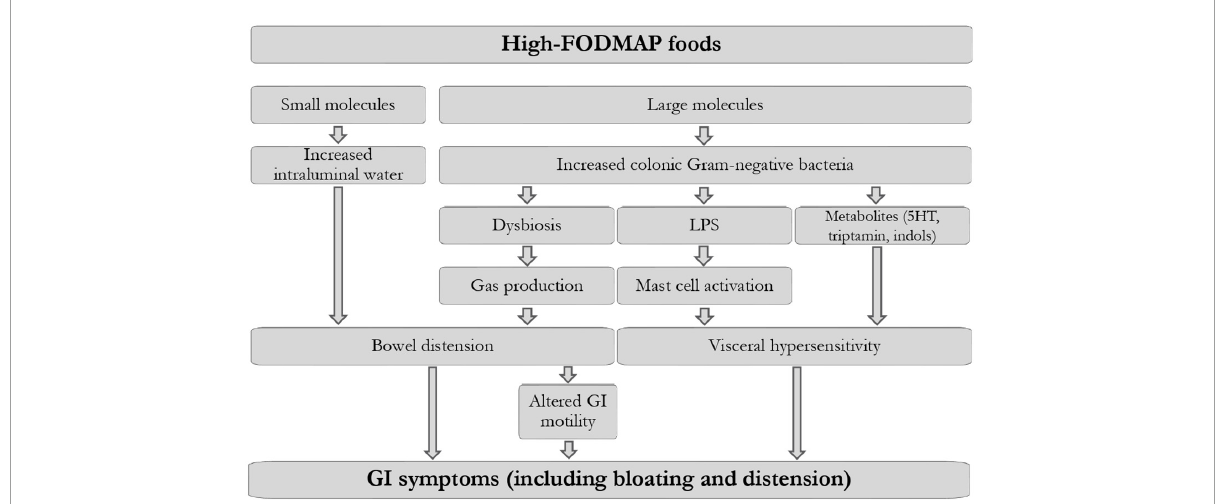
FIGURE1 Proposed pathogenetic mechanisms leading to gastrointestinal symptoms, including bloating, after FODMAPs ingestion in predisposed individuals. Modified from Singh et al. (47) and Van den Houte et al. (16). LPS, lipopolysaccharide; 5HT, 5-hydroxytryptamine; GI, gastrointestinal.